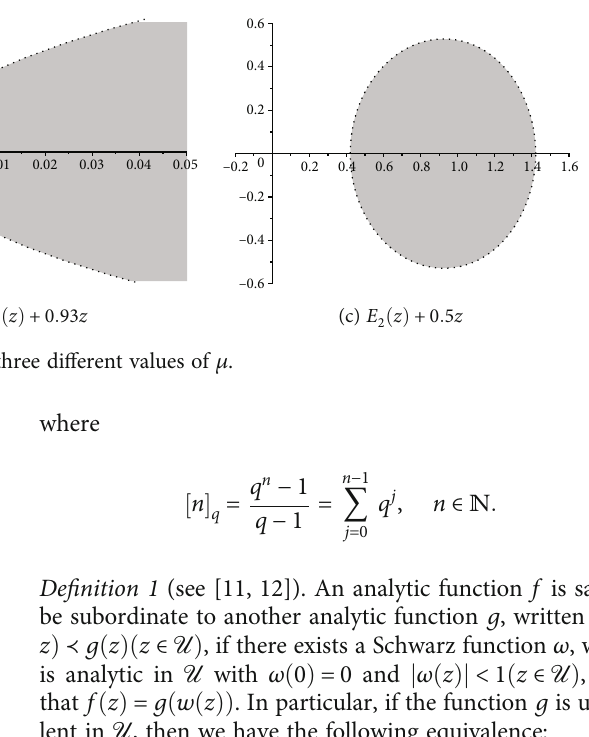
, E , E , and E . 1 2 3 4